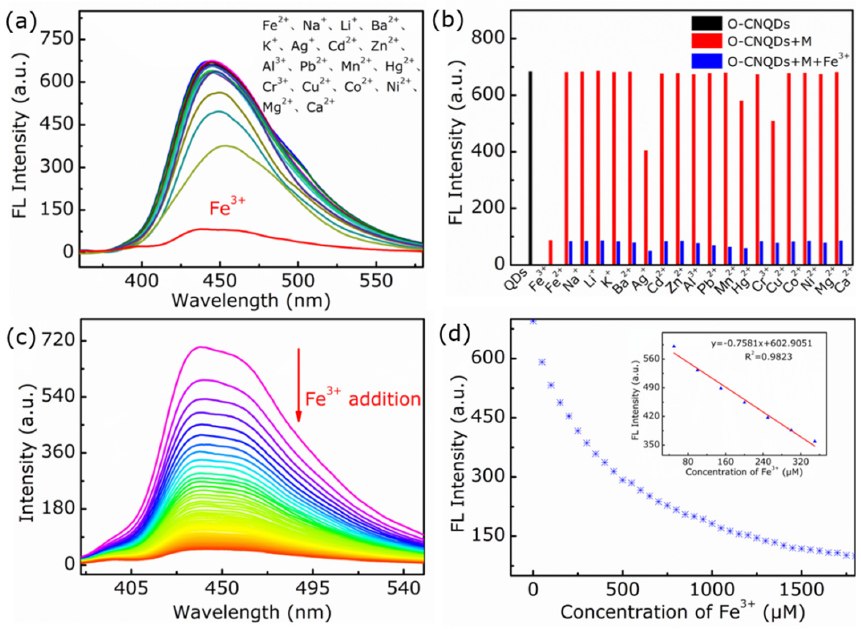
Figure 6. ( a , b ) Fluorescence intensity of OCNQDs in aqueous solution containing various metal ions (1500 μ M for Fe 3+ , Fe 2+ , Na + , Li + , Ba 2+ , K + , Ag + , Cd 2+ , Zn 2+ , Al 3+ , Pb 2+ , Mn 2+ , Hg 2+ , Cr 3+ , Cu 2+ , Co 2+ , Ni 2+ , Mg 2+ , and Ca 2+ ). ( c ) Fluorescence spectra of OCNQDs upon addition of various concentrations of Fe 3+ . ( d ) Relationship between fluorescence intensity of OCNQDs and concentration of Fe 3+ . Inset: the linear relationship of fluorescence intensity of OCNQDs versus the concentration of Fe 3+ over the range from 0.1 to 340 µ M.